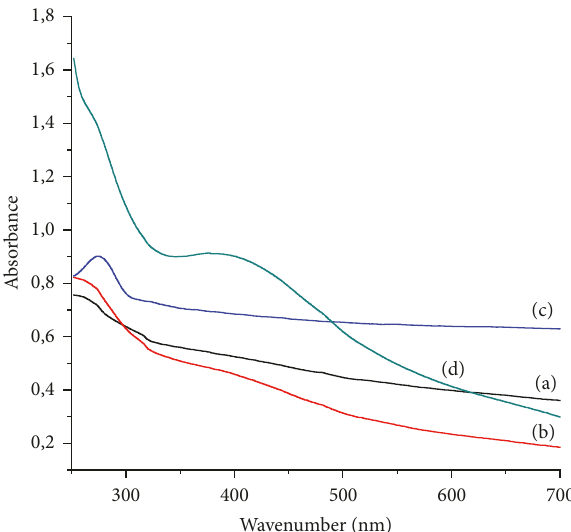
Figure 6: UV/vis spectra of aqueous solutions containing CoNPs after Co 8 (BH20) reduction (a), CoNPs after Co 10 (BH20) reduction (b), CoNPs after Co 12 (BH20) reduction (c), and CoNPs after Co 16 (BH20) reduction (d).